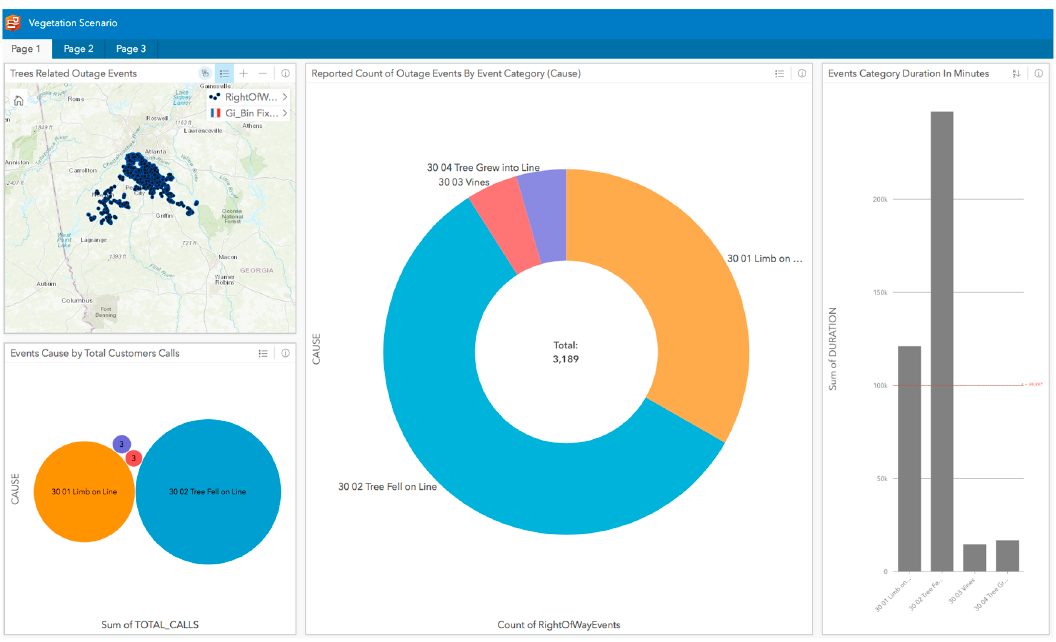
Figure 6. Challenge 1—Storm Scenario Workbook—Page 4.